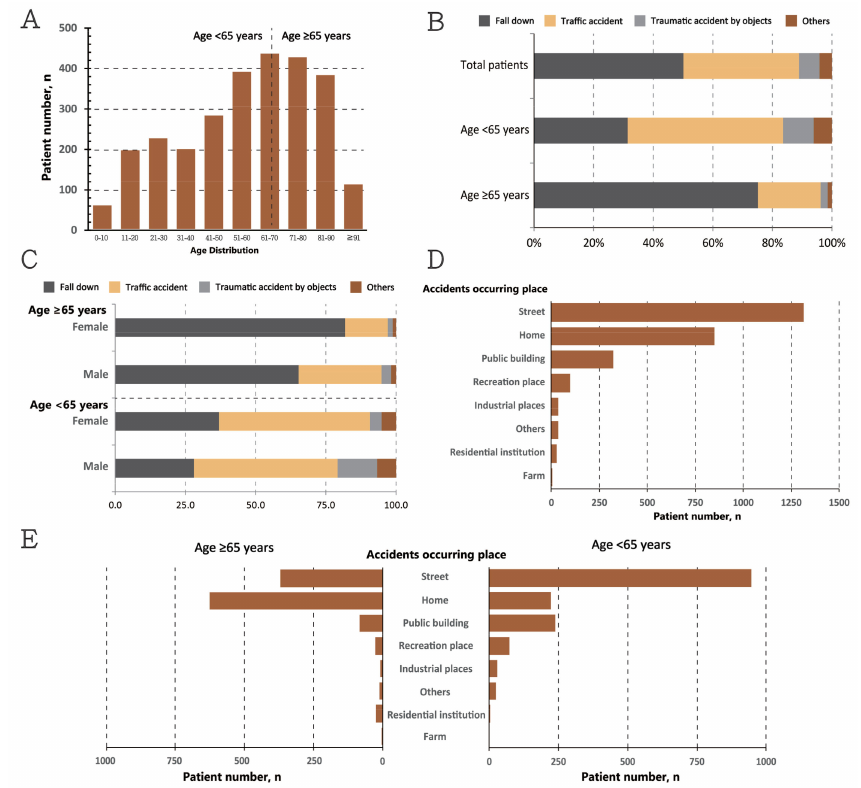
Figure 1. Clinical characteristics of the 2688 traumatic patients: ( A ) Age distribution in total patients; ( B ) The reasons for emergency admission in total patients and both groups; ( C ) The reasons for emergency admission with gender distribution; ( D ) The accidents occurring place in total patients; ( E ) The place of accidents in both